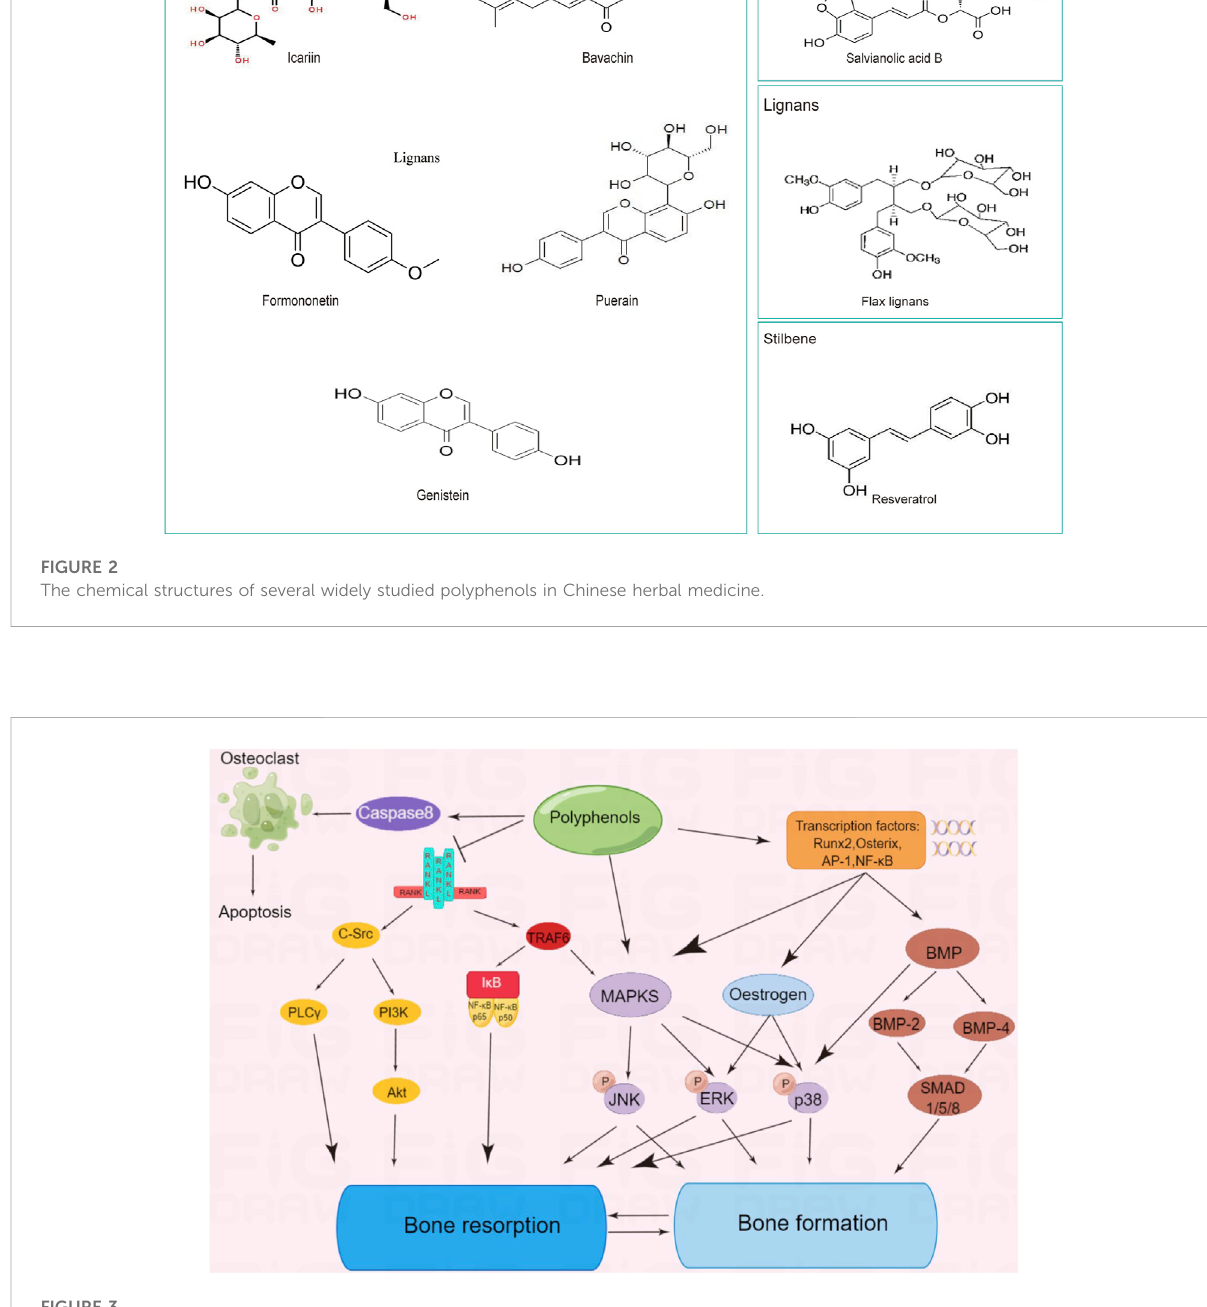
Polyphenols regulate multiple signaling pathways of bone formation or bone